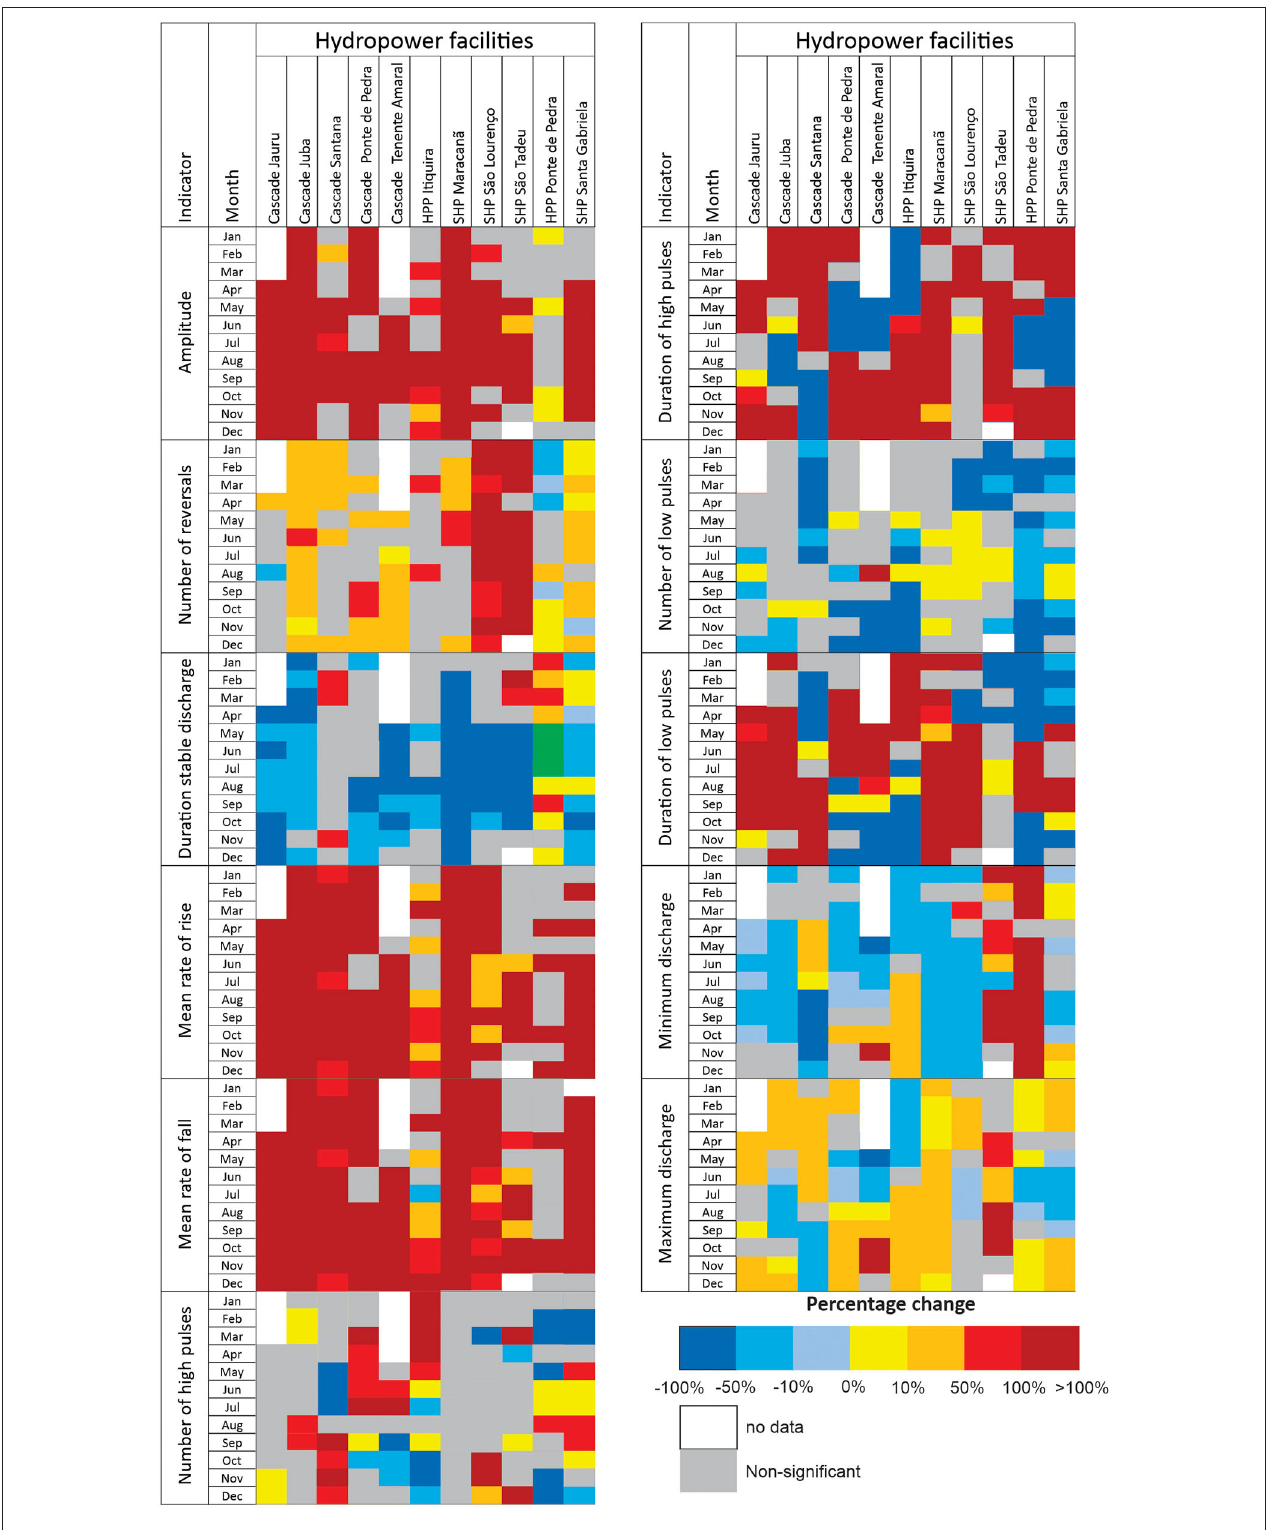
FIGURE 4 | Percentage change in sub-daily indicators of hydrological alteration for each study reach by month, showing only cases where there was a statistically significant difference (Mann-Whitney test) between the upstream reference site and the downstream site.